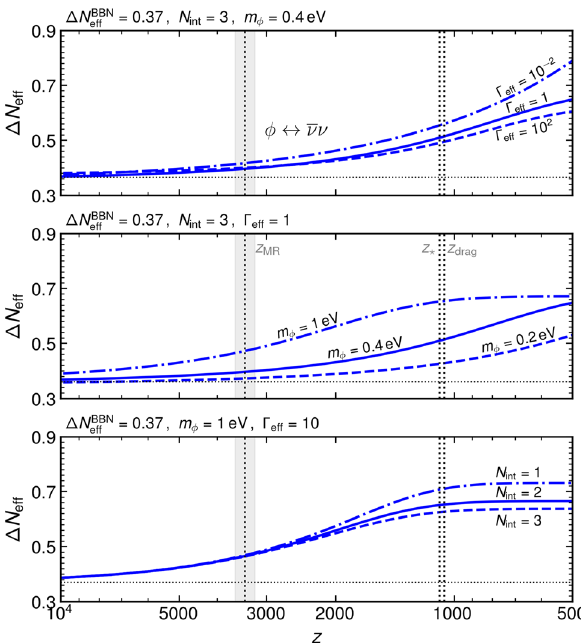
Fig. 4 Evolution of (cid:2) N eff as a function of redshift for the case (cid:2) N BBN = 0 . 37. Upper panel: evolution for a fixed value of m φ for dif- eff ferent values of the neutrino-majoron interaction rate (cid:15) eff , see Eq. (15). Middle panel: evolution for a fixed (cid:15) eff and for three representative val- ues of m φ . Lower panel: evolution fixing m φ and (cid:15) eff but with varying number of interacting neutrino species. We can appreciate that between matter-radiation equality and recombination (cid:2) N eff can easily grow up to ∼ 0 . 6 as a result of the φ ↔ ¯ νν